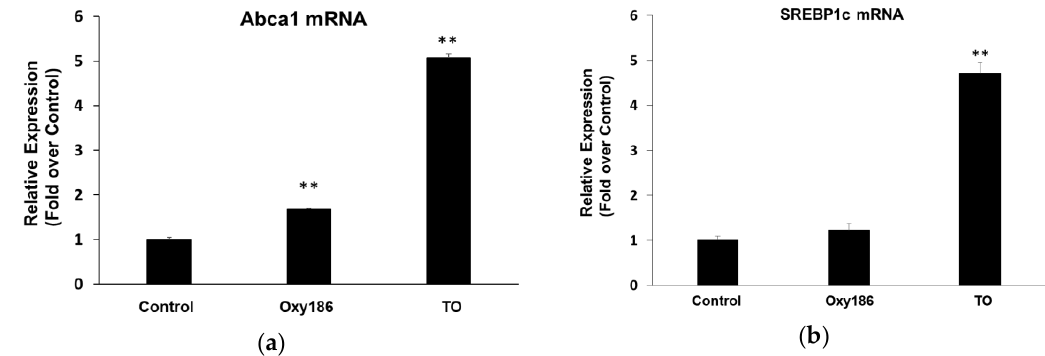
Figure 7. Induction of LXR target gene expression by Oxy186 and LXR agonist TO901317 (TO). ( a ) NIH3T3 cells and ( b ) HepG2 cells were treated with DMEM containing 5% FBS in the presence or absence of TO (2 µ M) or Oxy186 (10 µ M). After 48 h, RNA was extracted and analyzed by Q-RT-PCR for the expression of LXR target genes Abca1 in NIH3T3 cells and SREBP1c in HepG2 cells and normalized to Oaz1 or GAPDH expression, respectively. Data from a representative experiment are reported as the mean of triplicate determinations ± SD (** p < 0.01 vs. control).